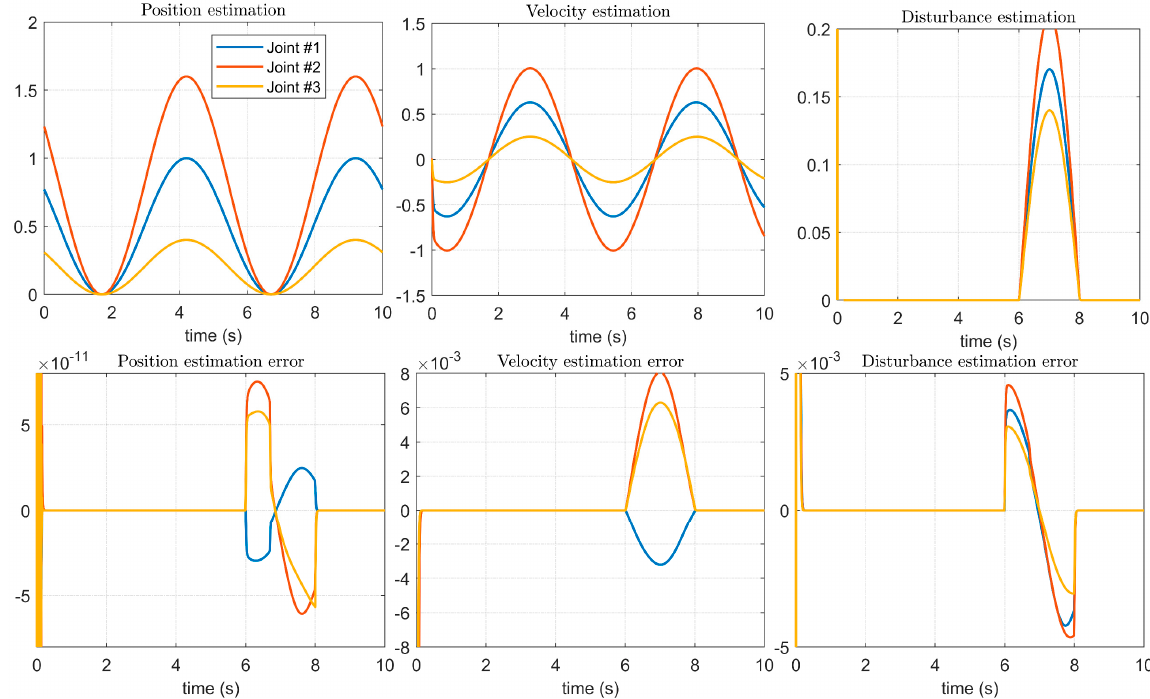
Figure 11. Estimation of control signals and disturbances using the proposed method.